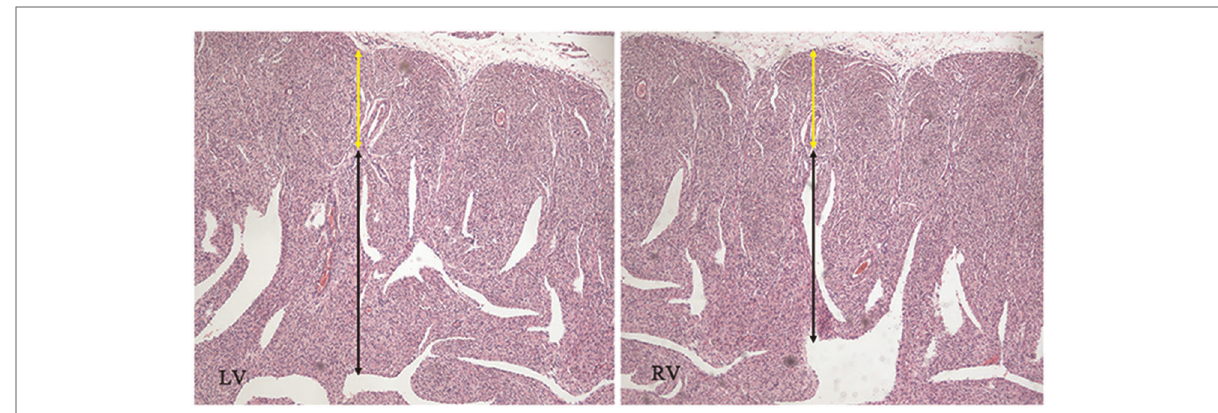
FIGURE 4 Histopathologic appearance of the myocardium at low magni fi cation (hematoxylin and eosin, ×40). The images were compatible with non-compaction cardiomyopathy, with cardiomyocyte disarray in the non-compacted layer (black arrow) in opposition to regular cardiomyocytes in the compacted layer (yellow